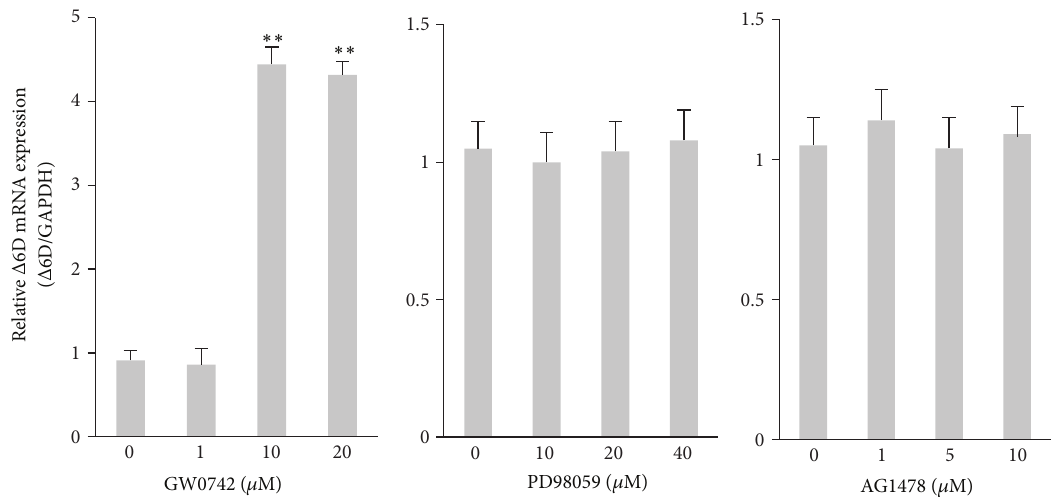
Figure 1: Effects of different doses of the PPAR 𝛿 agonist, selective inhibitor of MEK/ERK1/2, and EGF receptor-selective tyrosine kinase inhibitor on mRNA expression of Δ 6-desaturase ( Δ 6D) in PANC-1 human pancreatic tumor cells. Cells were treated with GW0742, PD98059, or AG1478 as indicated. One microgram of extracted RNA was reverse transcribed, and real-time RT-PCR to amplify Δ 6 desaturase and GAPDH cDNA fragments was performed as described. Relative expression with duplicate samples is given and was calculated by normalization to GAPDH and represented as mean ± SE from 3 independent experiments. Data are means ± SE, 𝑛 = 3 . ∗∗ : 𝑃 < 0.01 for Student’s 𝑡